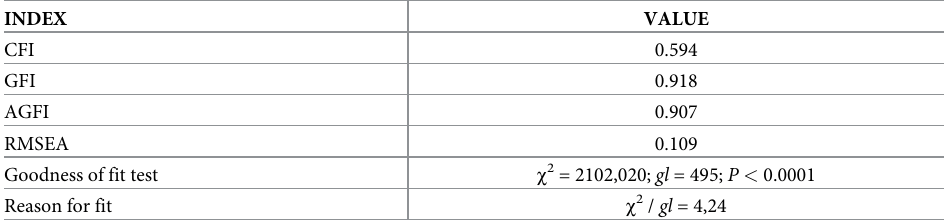
CFI: Comparative Fit Index. GFI: Goodness of Fit Index. AGFI: Adjusted Goodness of Fit Index. RMSEA: Root Mean Standard Error of